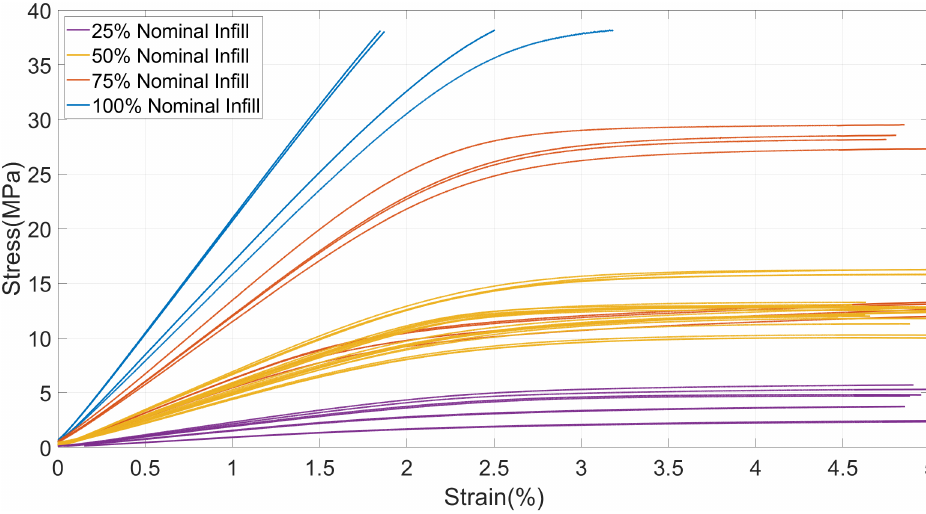
Figure 10. Longitudinal stress–strain curves from the compression experiments.